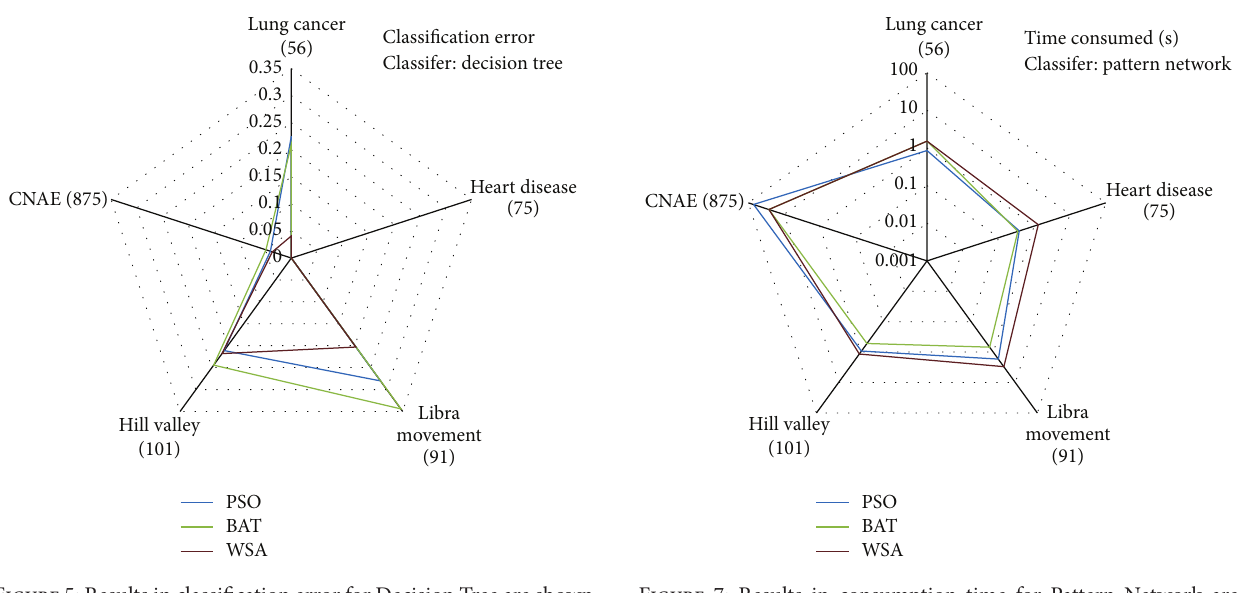
Figure 7: Results in consumption time for Pattern Network are shown visually in radar chart.